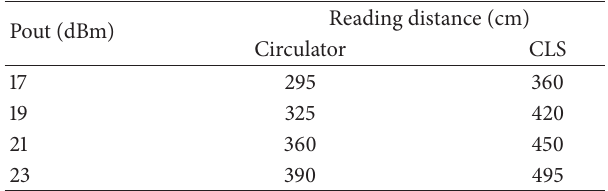
Table 1: Summary of the components’ specification. Table 2: Summary of the reading